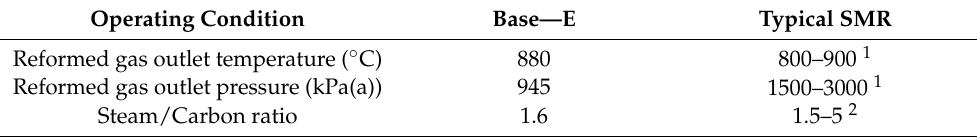
Table 7. Comparison of Base—E reformer operating conditions to typical steam methane reforming.